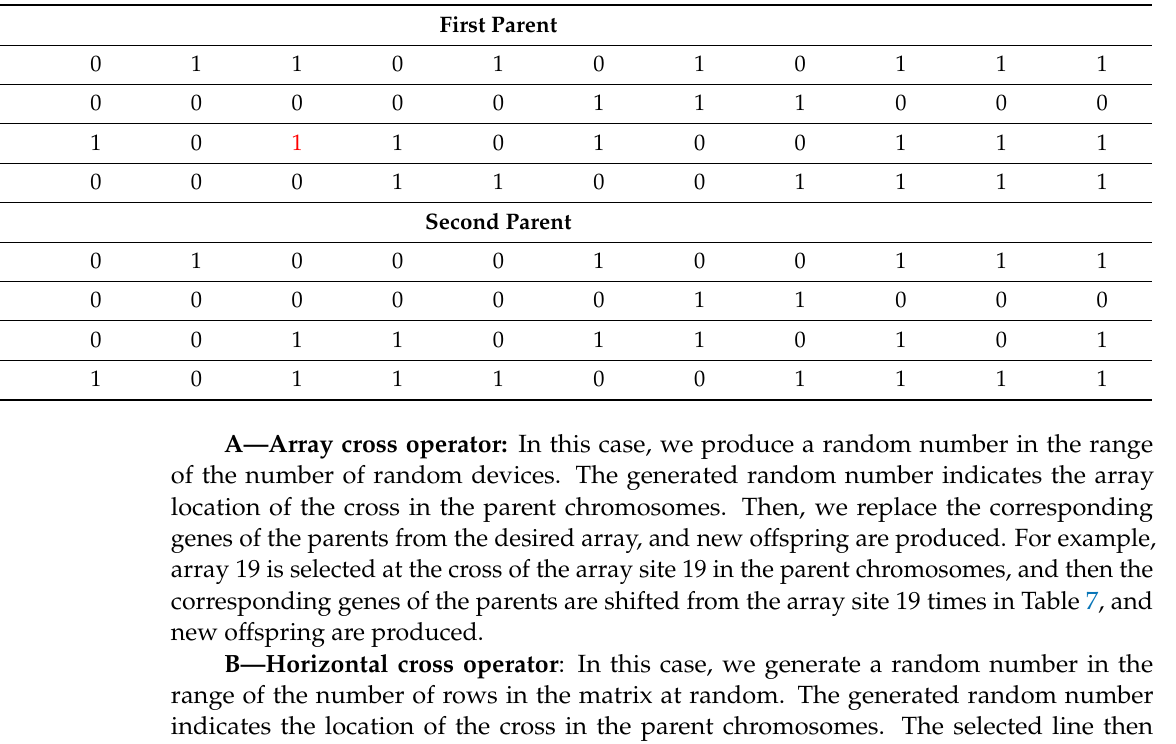
Table 6. Two hypothetical parent